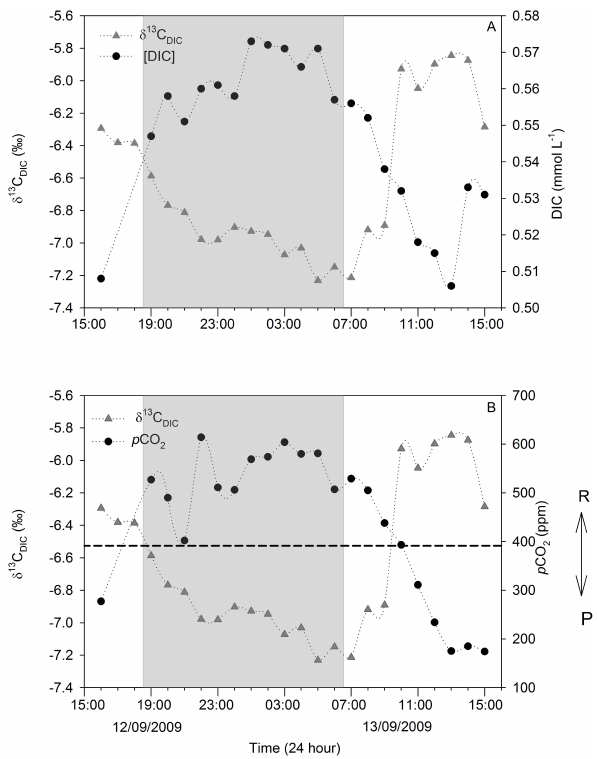
Fig. 12. Diurnal fluctuations of (A) δ 13 C DIC and DIC concentra- tions, and (B) δ 13 C DIC and p CO 2 at Chania Stream. Night-time is indicated in